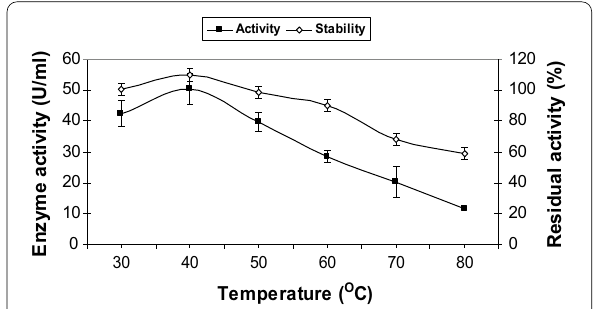
Fig. 2 Activity and stability of l -glutaminase produced by Bacillus sp. DV2-37 as a function of temperature. Results are means of three independent determinations. Data represent the mean of 3 different readings standard deviation ±